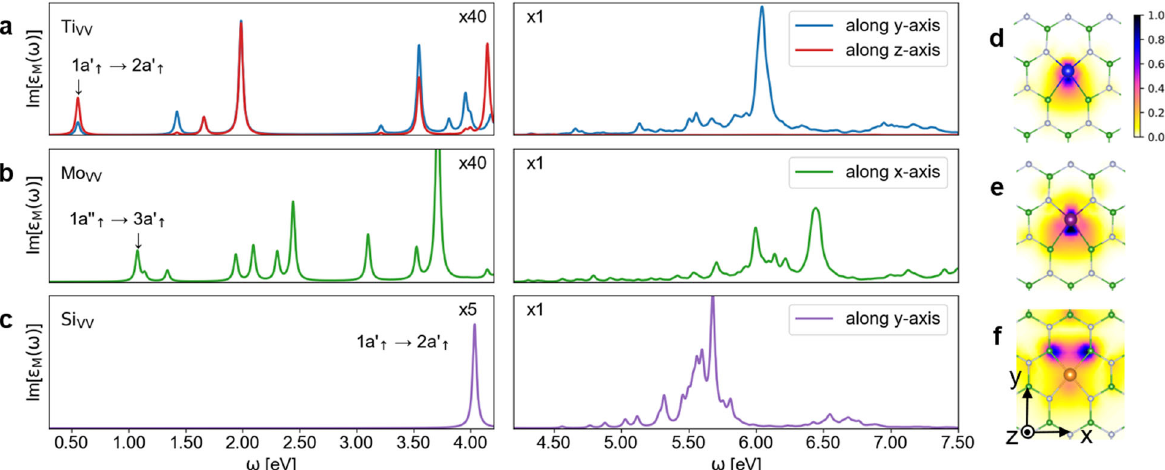
Fig. 3 BSE optical spectra and exciton wavefunctions. Absorption spectra of the a Ti VV , b Mo VV , and c Si VV defects in h -BN at the level of G 0 W 0 + BSE @ PBE0( α ). The left and right panels provide absorption spectra for two different energy ranges, where the former is magni fi ed by a factor of 40 for Ti VV and Mo VV and a factor of 5 for Si VV for increasing visibility. A spectral broadening of 0.02 eV is applied. The exciton wavefunctions of d Ti VV , e Mo VV and f Si VV are shown on the right for the fi rst